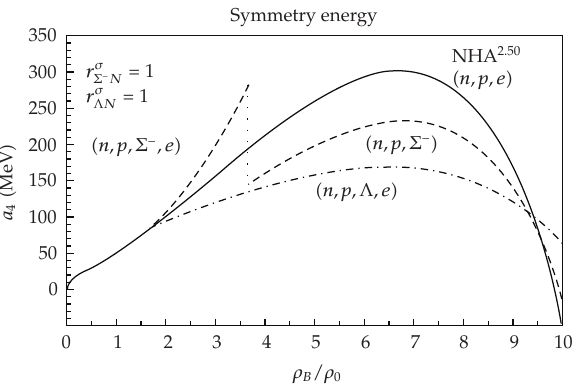
Figure 8: Nucleon symmetry energies of (cid:7) n,p,e (cid:8) , (cid:7) n,p, Σ − ,e (cid:8) , and (cid:7) n,p, Λ ,e (cid:8) are shown with the solid, doted, and dot-dashed lines, respectively. The ratios of hyperon coupling constants are r σ Σ − (cid:5) 1 . 0. The discontinuity of symmetry energy, (cid:7) n,p, Σ − ,e (cid:8) , occurs at ρ r σ Λ N phase transition from (cid:7) n,p, Σ − ,e (cid:8) to (cid:7) n,p, Σ − (cid:8)